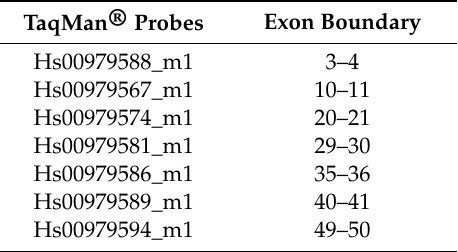
Table 2. Localization of the TaqMan probes within the ABCA4 gene exons.